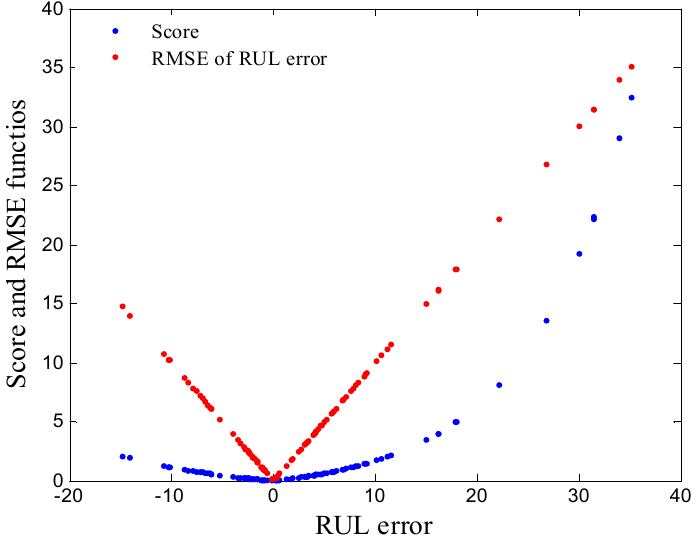
Figure 4. Scoring functions for the testing set